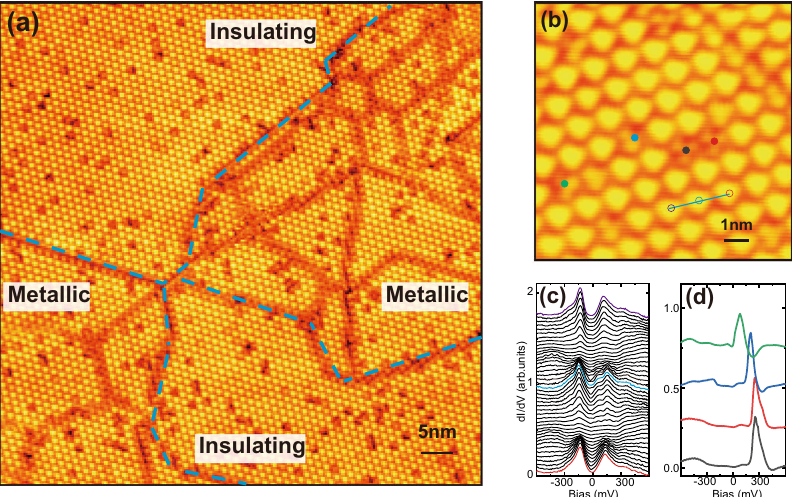
Fig. 4 Topography and electronic state for a x = 0.01 sample. a A 75 × 75 nm 2 topography ( V b = − 1 V, I s = 100 pA) shows the coexistence of insulating large domains and metallic small domains. b A 10 × 10 nm 2 topography insides a metallic domain. The gray, red, blue, and green circles mark four different Ti-doped SDs. c A series of dI / dV spectra measured along the blue line in b . d Four typical dI / dV spectra on symmetric and asymmetric Ti-doped SDs.